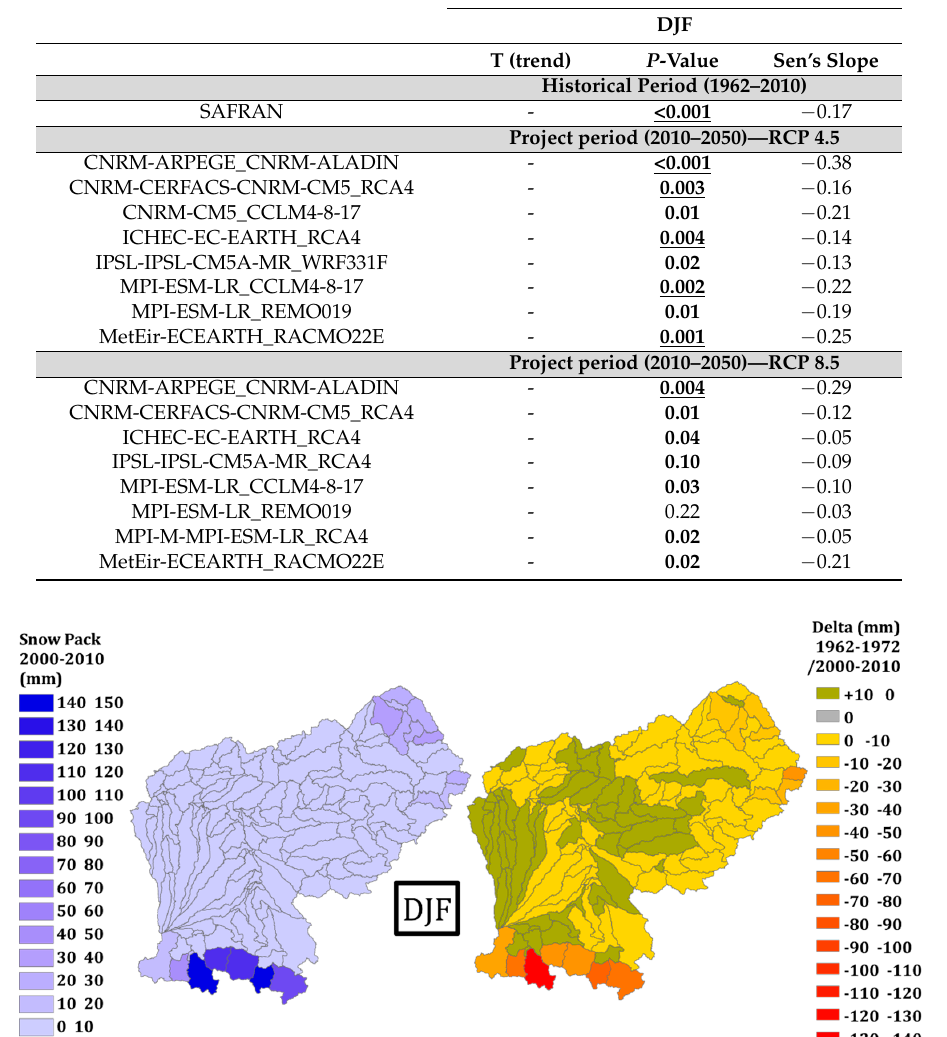
Table 8. Trend in surface run off over winter (DJF) and summer (JJA) seasons at watershed scale, for SAFRAN (historical period) and climatic ensemble (projected period). Bold numbers are significant trend considering α = 0.1 and underlined numbers considering α = 0.05.